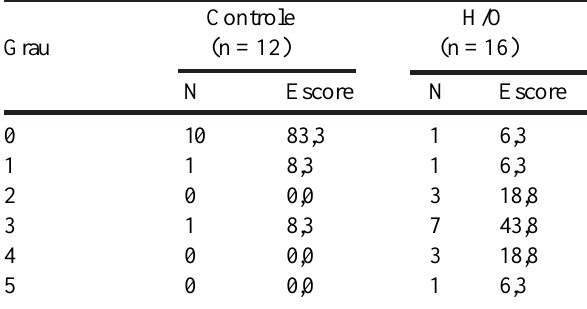
Grau de lesão tecidual no cólon (Tabela 3) Foi encontrada diferença estatisticamente significante entre os grupos de estudo quanto à distribuição do grau de lesão tecidual no cólon dos animais (p = 0,003), onde o grupo G1 apresentou graus significantemente menores do que os dos grupos